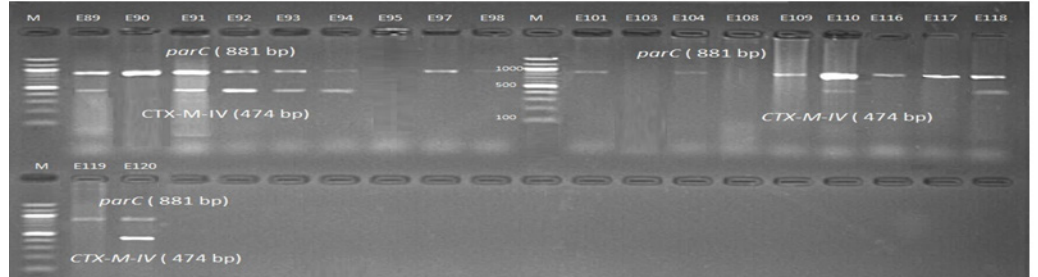
Fig. 8. 1.5% Agarose gel electrophoresis at 72 volt for 90 minutes of PCR to blaCTX-M-IV amplicon (474bp) lane